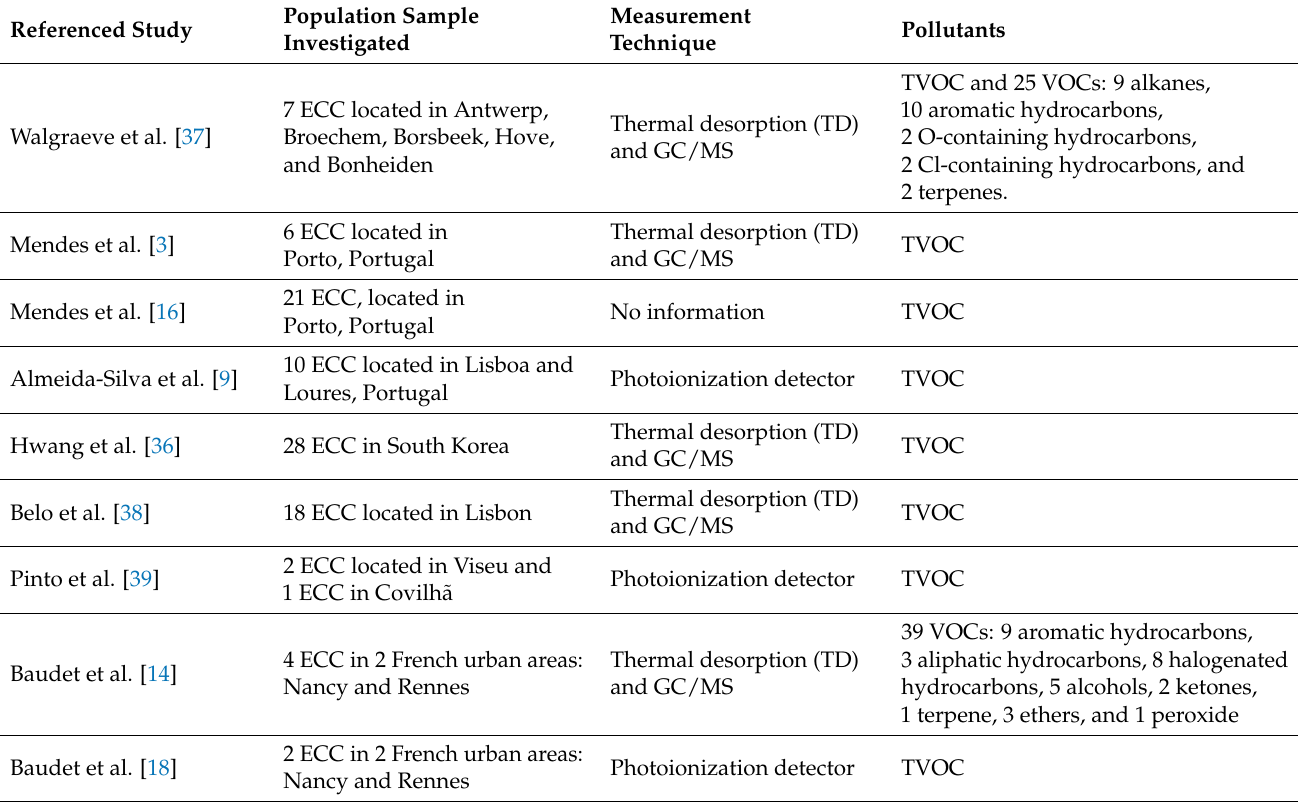
Table 1. VOCs measurements conducted in Elderly Centers studies.